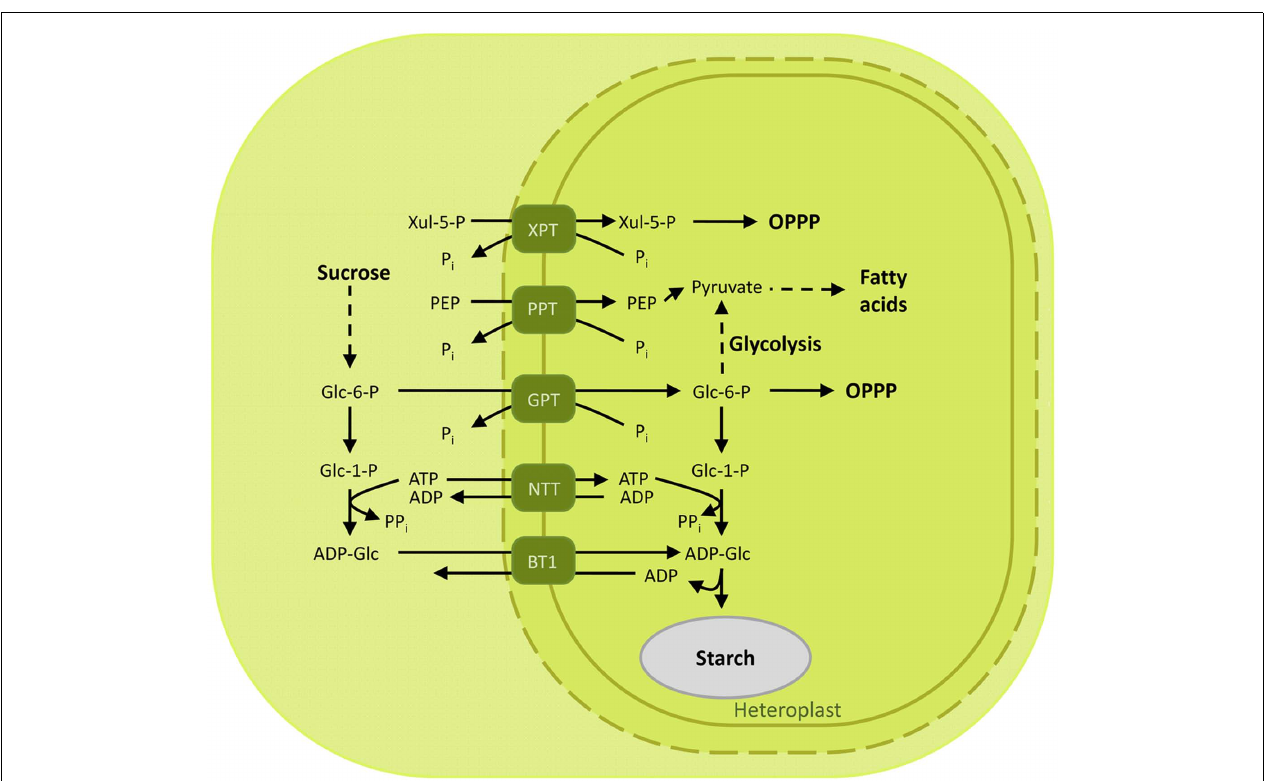
transporter. Abbreviations: ADP-Glc, ADP-glucose; BT1, Brittle-1 ADP-glucose carrier; Glc 1-P, glucose 1-phosphate; Glc 6-P, glucose 6-phosphate; GPT, glucose 6-phosphate/phosphate translocator; Mal, maltose; NTT, nucleoside triphosphate transporter; OPPP, oxidative pentose phosphate pathway; 3-PGA, 3-phosphoglyceric acid; PEP, phospho enol pyruvate; Pi, inorganic phosphate; PPi, pyrophosphate; PPT, PEP/phosphate translocator;